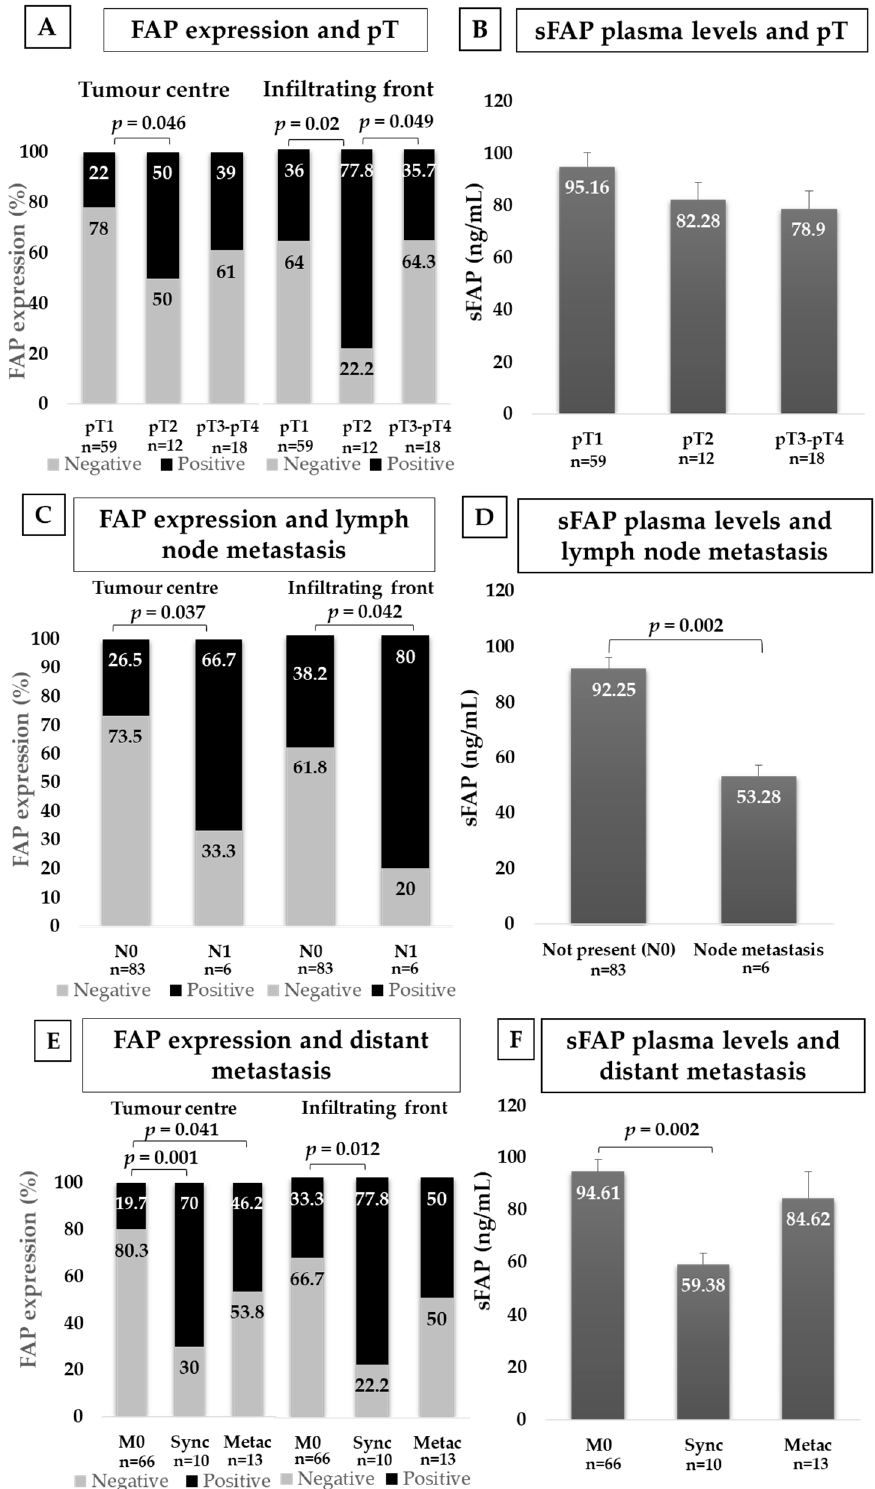
Figure 3. Immunohistochemical FAP staining and plasma levels of sFAP according to CCRCC aggressiveness. FAP immunostaining in centre and border of tumours and sFAP levels in plasma from CCRCC patients depending on local invasion ( A , B ), locoregional lymph node invasion ( C , D ) and distant metastasis ( E , F ). FAP staining intensity was scored as negative or positive and Chi-square test was used for comparisons. Results in plasma samples were analysed with Mann–Whitney U-test. N0: No lymph node metastasis; N1: lymph node metastasis; M0: No distant metastasis; Sync: Synchronous distant metastasis; Metac: Metachronous distant metastasis.